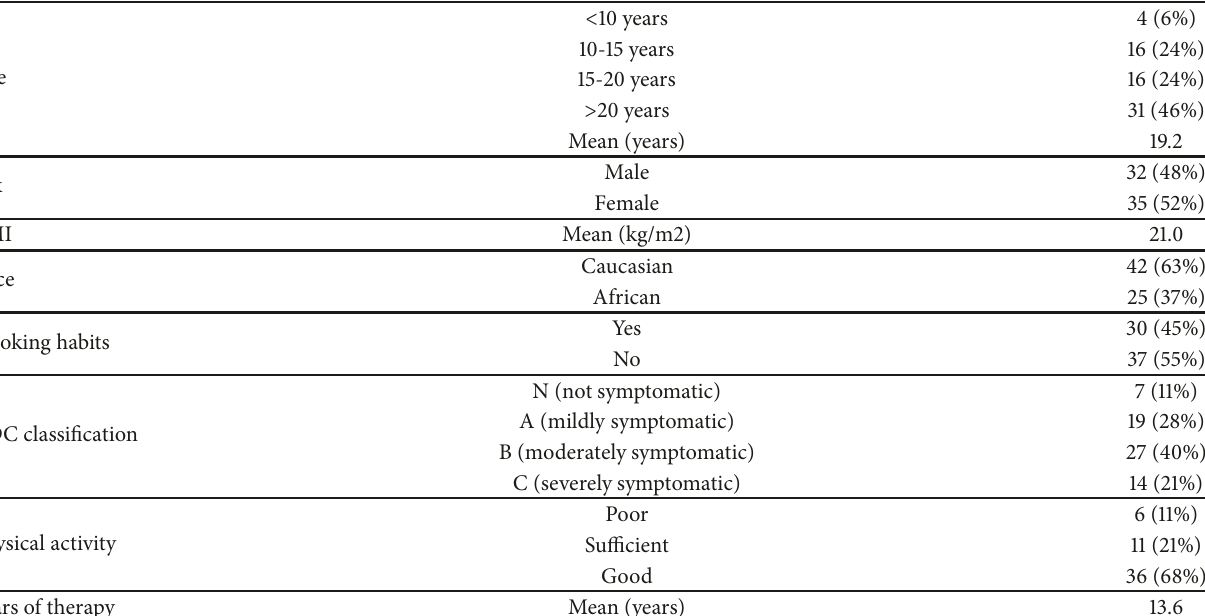
Table 1: Characteristics of the study population.